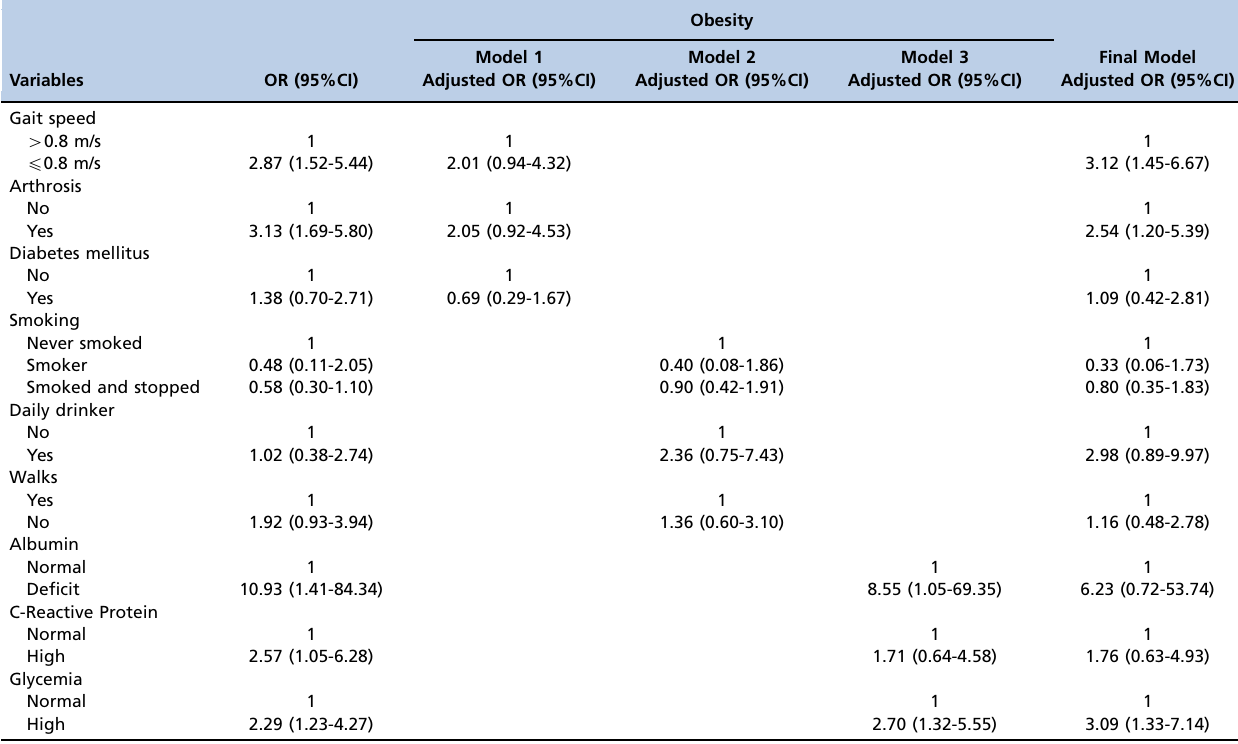
Table 5 - Crude and adjusted odds ratios (OR) and respective 95% confidence intervals (95%CI) for the association between obesity and functional variables and morbidities, lifestyle and biomarkers (FIBRA-RJ